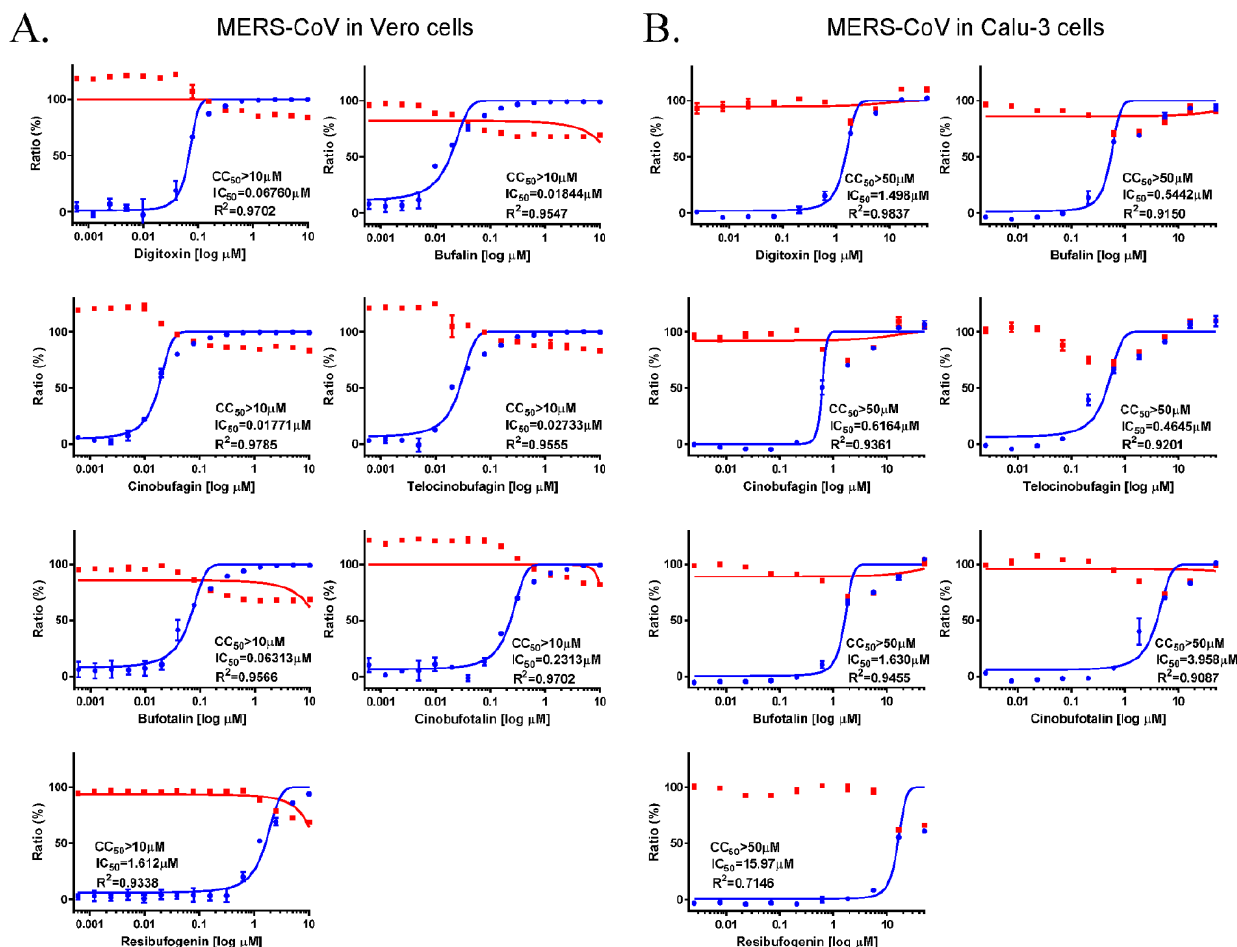
Figure 1. Anti-MERS-CoV activity of the cardiotonic steroids digitoxin, bufalin, cinobufagin, telocinobufagin, bufotalin, cinobufotalin, and resibufogenin. ( A ) The dose–response curve analysis by immunofluorescence staining was performed to determine the antiviral effect of the cardiotonic steroids, ranging between 0.001 and 10 µ M in Vero cells. ( B ) The dose–response curve analysis of the viral cytopathic effect was performed to determine the antiviral effects of cardiotonic steroids, ranging between 0.01 and 10 µ M in Calu-3 cells. Inhibition of MERS-CoV infection (%; blue circles) and cell viability (%; red squares) were indicated. The IC 50 values were calculated using non-linear regression analysis. The data represent duplicate experiments and are presented as the mean ± SEM.